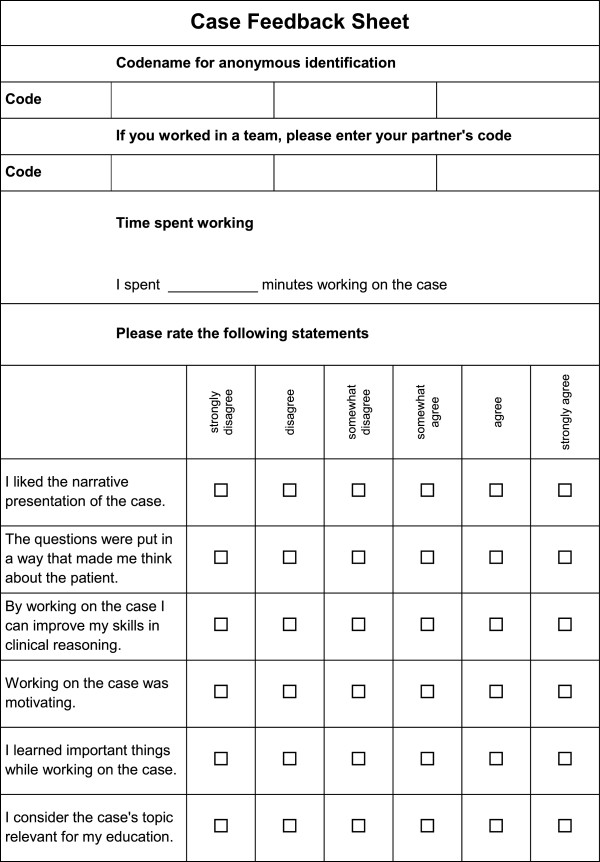
Case feedback sheet.